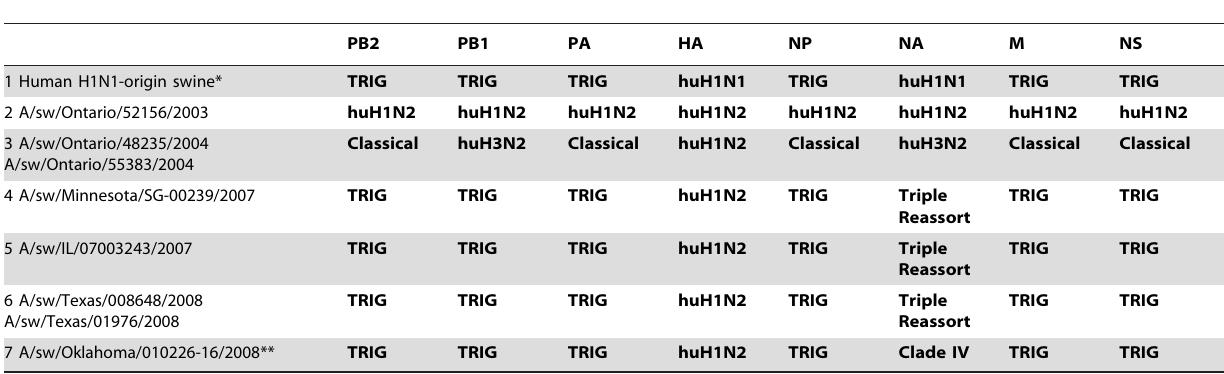
Summary of reassortment events involving 31 human-like swine influenza virus isolates. The phylogenetic position of each isolate or cluster of related isolates is classified for each segment according to nomenclature and color-coding used in Figs. 3 and 4 and Figs. S2, S3, S4, S5, S6, and S7: human H1N1 (huH1N1), human